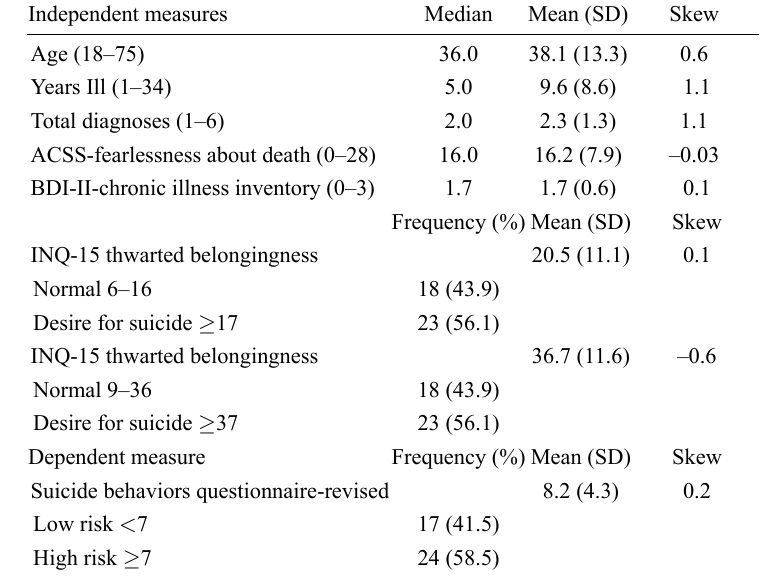
Table 1. Descriptive statistics for continuous variables and the self-report scales (n =